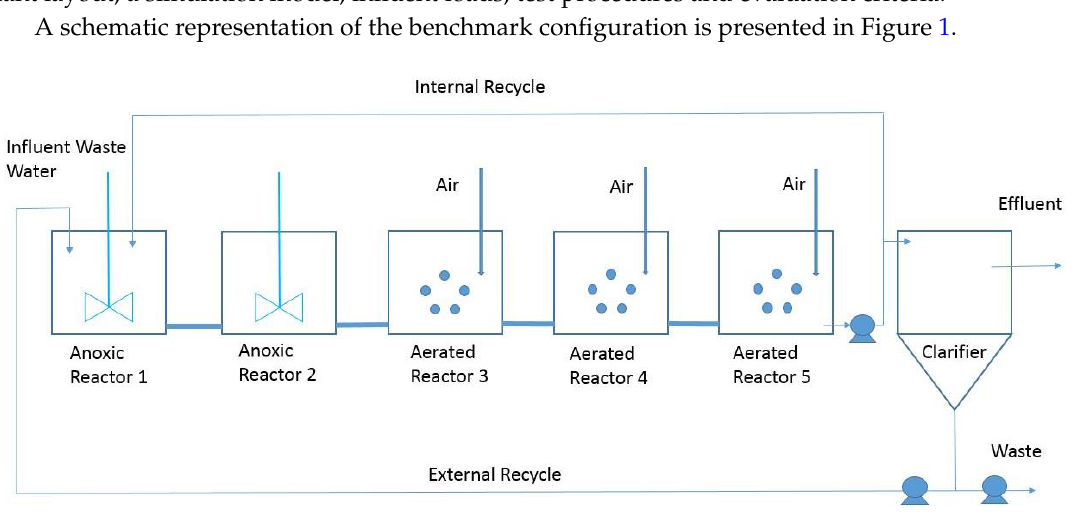
Figure 1. Plant layout of the Benchmark Simulation Model No. 1 ( BSM1 ).